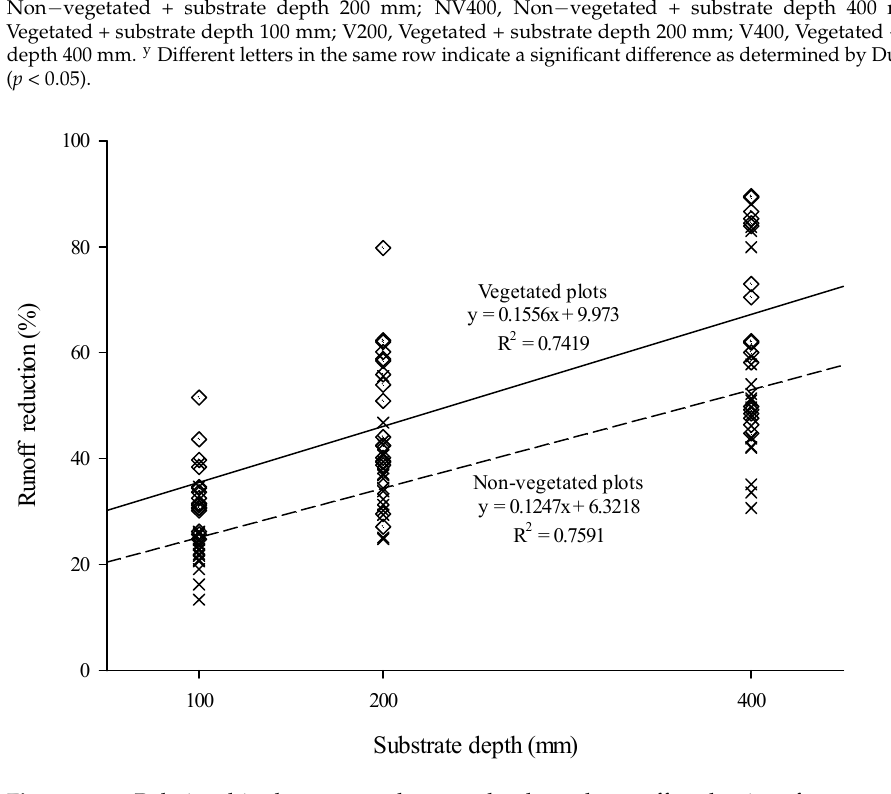
Figure 2. Relationship between substrate depth and runoff reduction from vegetated or non − vegetated plots.